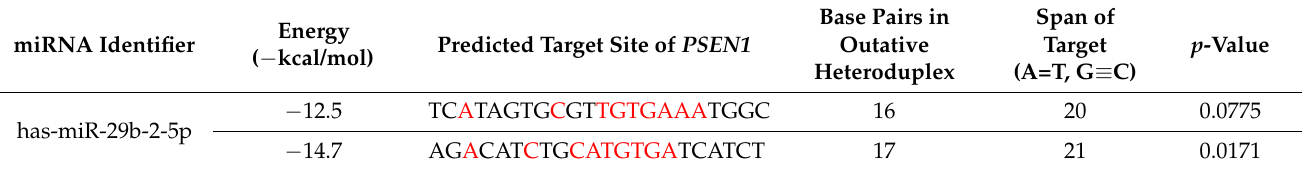
Table 2. Prediction of miRNA-29b-2-5p— PSEN1